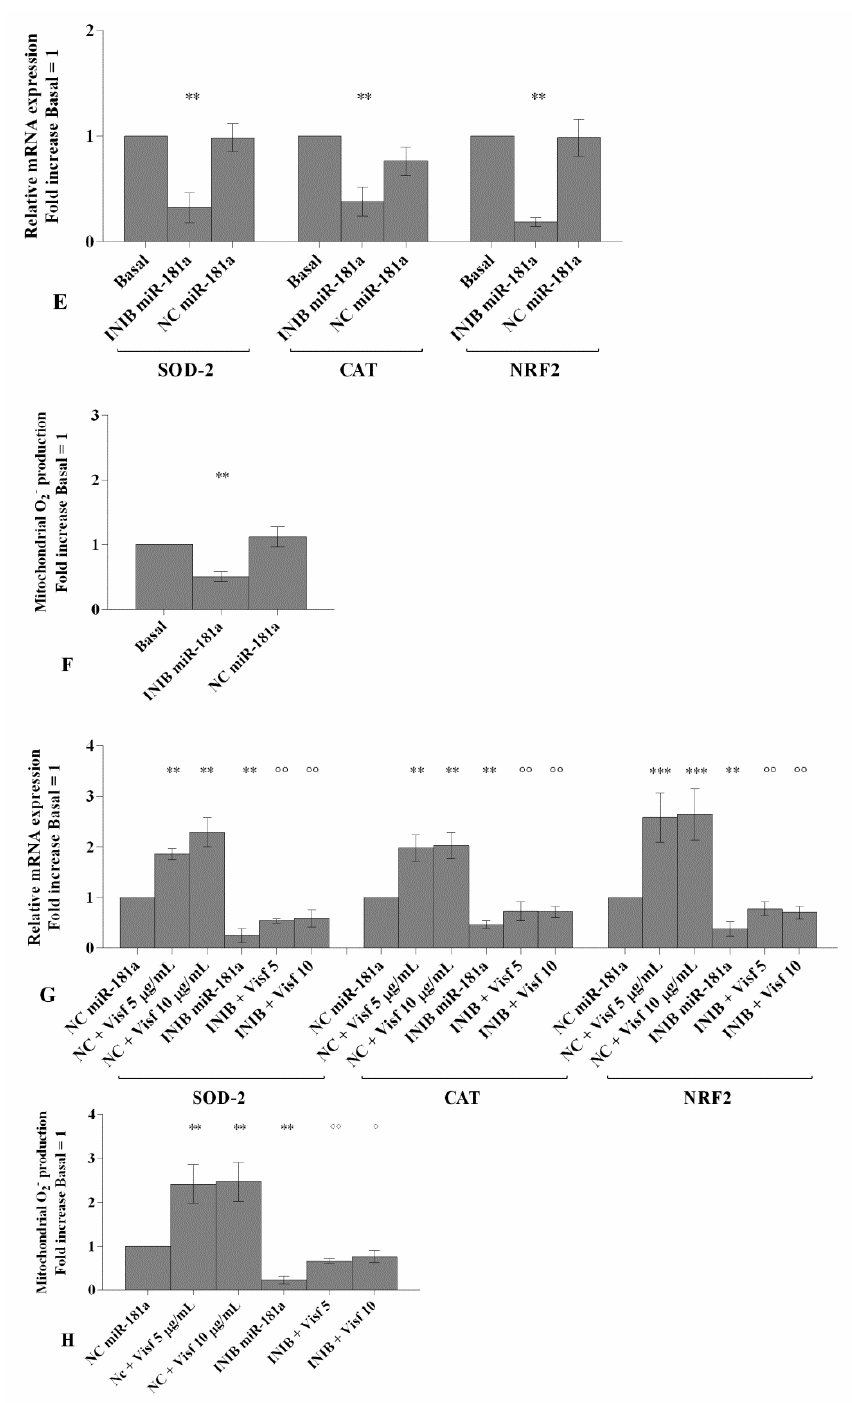
Figure 4. ( A , C , E , G ) Expression levels of superoxide dismutase (SOD-2), catalase (CAT), nuclear factor erythroid 2 like 2 (NRF2) by real-time PCR. ( B , D , F , H ) The production levels of mitochondrial superoxide anion by flow cytometry analysis using MitoSox Red staining. Human osteoarthritic (OA) chondrocytes were evaluated at basal condition, after 24 h of transfection with miR-34a and miR-181a inhibitors (50 nM) or NC (5 nM) and after 24 h of stimulus with visfatin (5 µ g / mL and 10 µ g / mL). The gene expression and the production of superoxide anion were referenced to the ratio of the value of interest and basal condition (Basal, cells without treatment) or NC. The value of basal condition or NC were reported equal to 1. Data were expressed as mean ± SD of triplicate values. ** p < 0.01, *** p < 0.001 versus basal condition or NC. ◦ p < 0.05, ◦◦ p < 0.01 versus inhibitor. INIB = Inhibitor, NC = negative control siRNA, Visf =